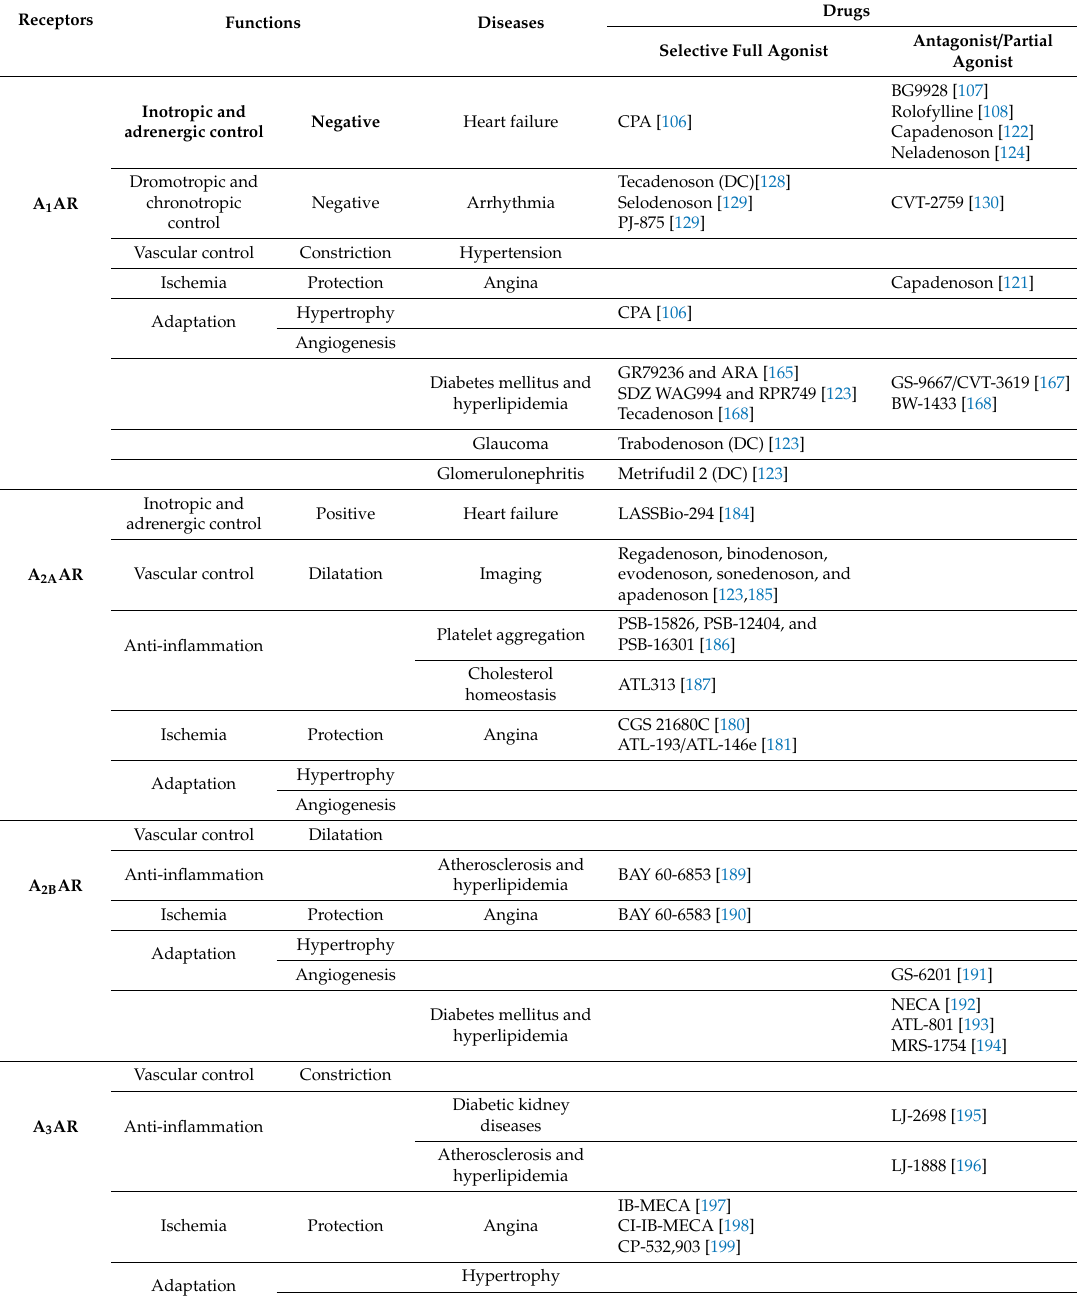
Table 2. Adenosine receptor drugs in cardiovascular and metabolic